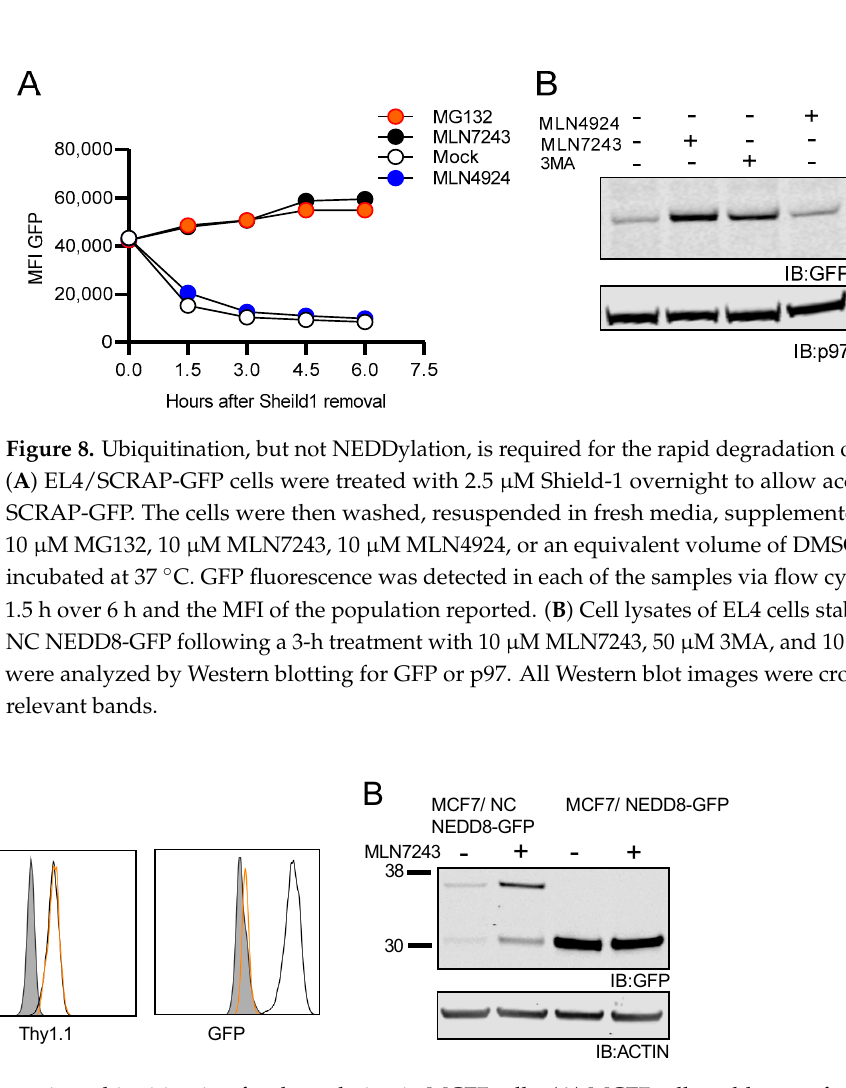
Figure 9. NC NEDD8-GFP requires ubiquitination for degradation in MCF7 cells. ( A ) MCF7 cells stably transfected with either NEDD8-GFP (black trace) or NC NEDD8-GFP (orange trace) vectors were analyzed by flow cytometry for Thy1.1 expression (left panel) and fluorescent GFP (right panel) compared to the parental cells (shaded histogram). ( B ) MCF7/NC NEDD8-GFP and EL4/NEDD8-GFP cells were treated with MLN7243 for 3 h and cell lysates analyzed by Western blot analysis. All Western blot images were cropped to show relevant